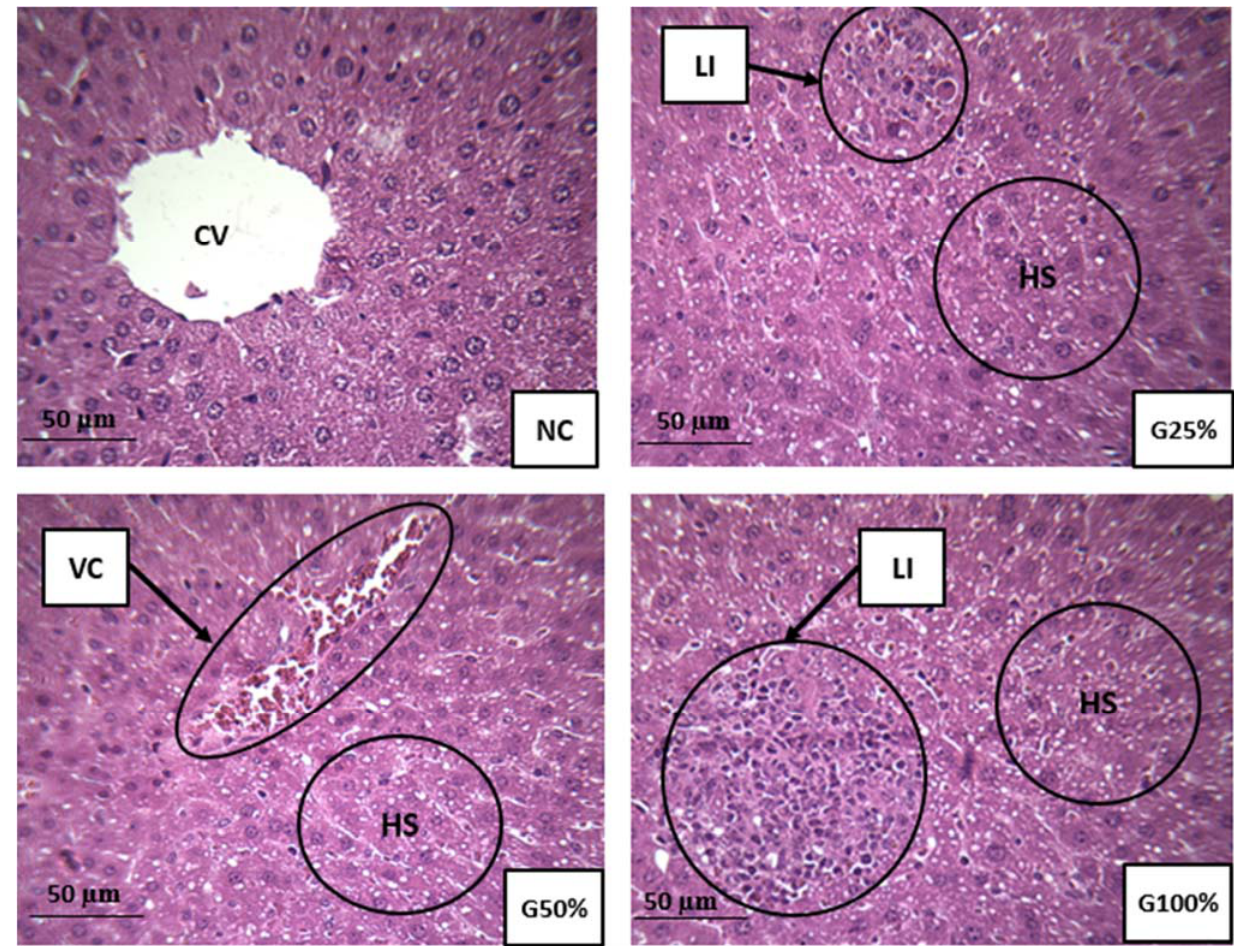
Figure 2. Histological sections of the liver from mice exposed to various dilutions of TDE (H&E, ×400). NC: liver section from negative control mice group showing apparently a healthy architecture of hepatocytes. G25%: liver sections of mice receiving 25% diluted TDE. G50%: liver sections of mice receiving 50% diluted TDE. G100%: liver sections of mice receiving 100% TDE. CV, central vein; LI, leucocyte infiltration; VC, vascular congestion of the central vein; HS, hepatic steatosis.